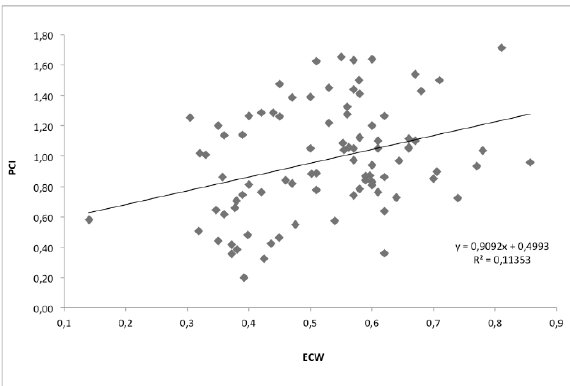
Figure 2: Correlation between PCI and ECW during treadmill walking test with 0% slope, (p=0.075).